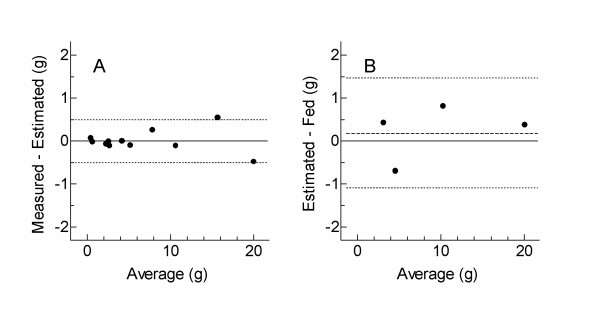
Bland-Altman plots. The dashed line represents the mean difference (on graph A, the difference = 0) and the dotted lines represent the 95% limits of agreement. A: comparison of measured and estimated GL values for 0, 5, 10 and 20 g carbohydrate from white bread and glucose and 4 low-carbohydrate foods. Measured values were calculated from the regressions of AUC on dose of glucose ingested for each subject; estimated values were derived from EGL. B: comparison GL values estimated from EGL for 3, 5, 10 and 20 g oral glucose and the amount of glucose fed. GL was estimated from EGL using equation (11) (see text) as follows: GL = 0.78 × EGL - 0.2.